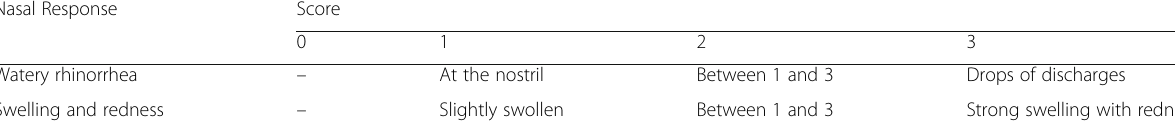
Table 1 Criteria for grading the severity of TDI-induced nasal responses in mice Nasal Response